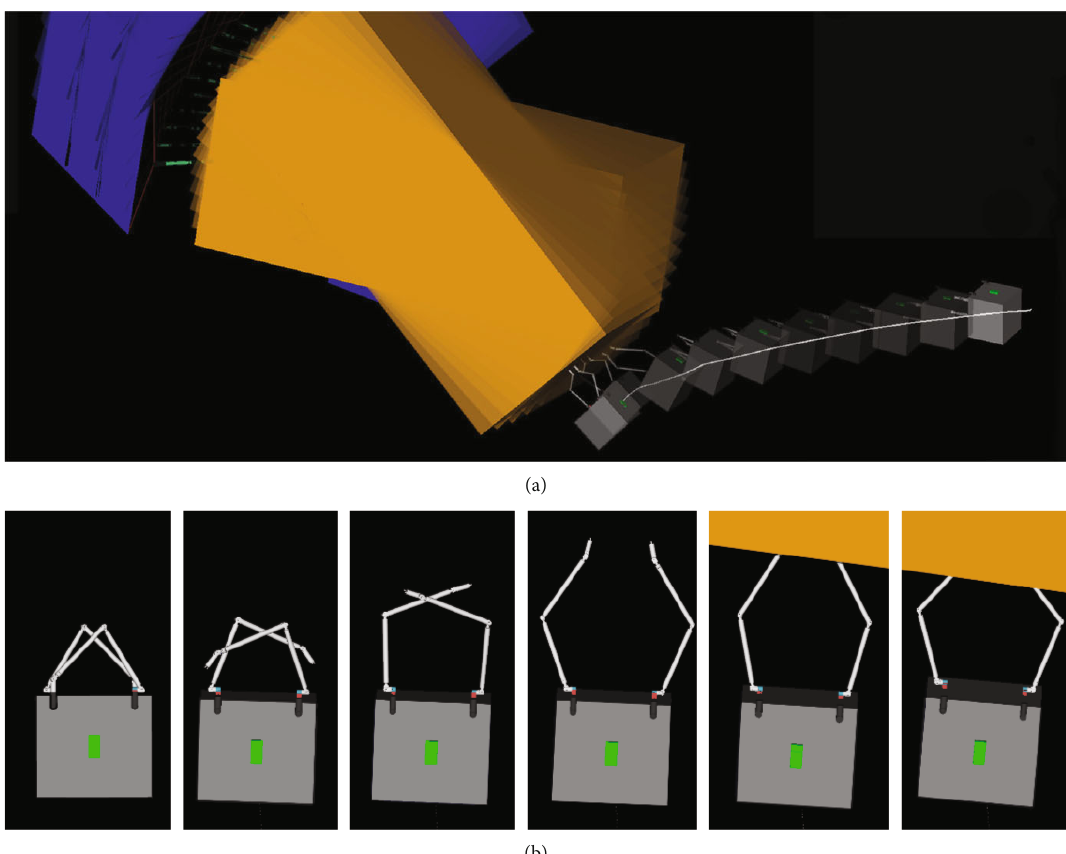
Figure 15: Flight history of the chaser in case 5. (a) The approach and capture process in the orbital coordinate system. (b) The attitude motion of the chaser and the deployment of the two manipulators from the negative z direction of the orbital coordinate